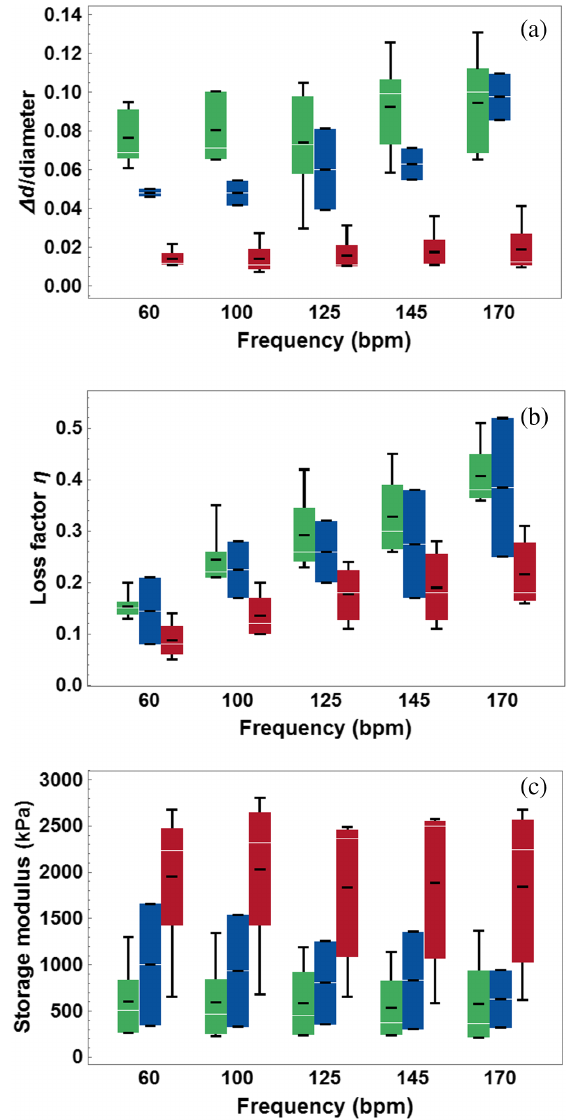
FIG. 7. Statistical analysis of the viscoelastic parameters at different pulse rates; maximum, minimum, 1st quartile, 3rd quartile, average (black horizontal line inside the box) and median (white horizonal line in the box) are reported for 3 age groups, green rectangular box, 25 – 44 years old; blue rectangular box, 45 – 59 years old; red rectangular box, 60 – 85 years old: (a) maximum relative diameter change; (b) loss factor; (c) storage